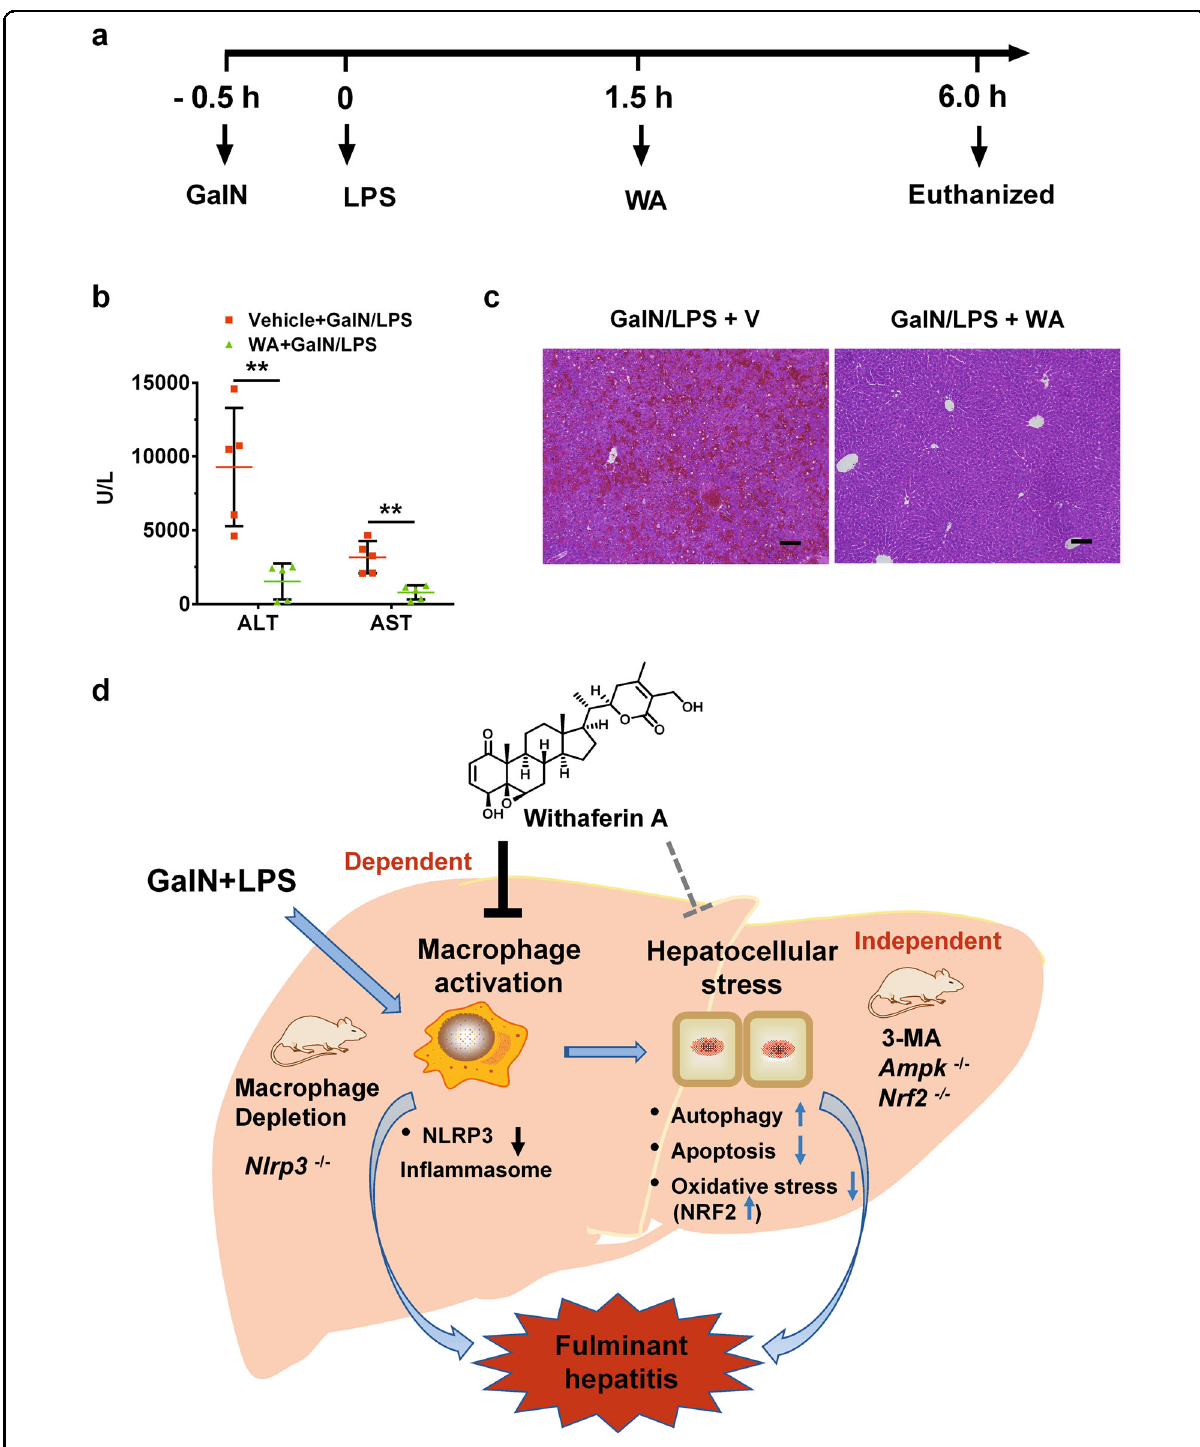
Fig. 7 WA therapeutically alleviated GalN/LPS-induced liver injury. a Experimental time scheme. b Serum ALT and AST levels in GalN/LPS- treated mice followed by vehicle (V) or WA treatment. c Representative hepatic H&E staining of V or WA-treated WT mice subjected to GalN/LPS challenge, scale bar 50 µm. d graphic abstract for major fi ndings and proposed mechanism. Unpaired two-tailed Student ’ s t test was used for statistical analyses. GalN/LPS + V, mice treated with GalN/LPS followed by vehicle treatment; GalN/LPS + WA, mice treated with GalN/LPS followed by WA treatment. Data were presented as mean ± SD ( n = 5). ** p < 0.01 versus GalN/LPS + V